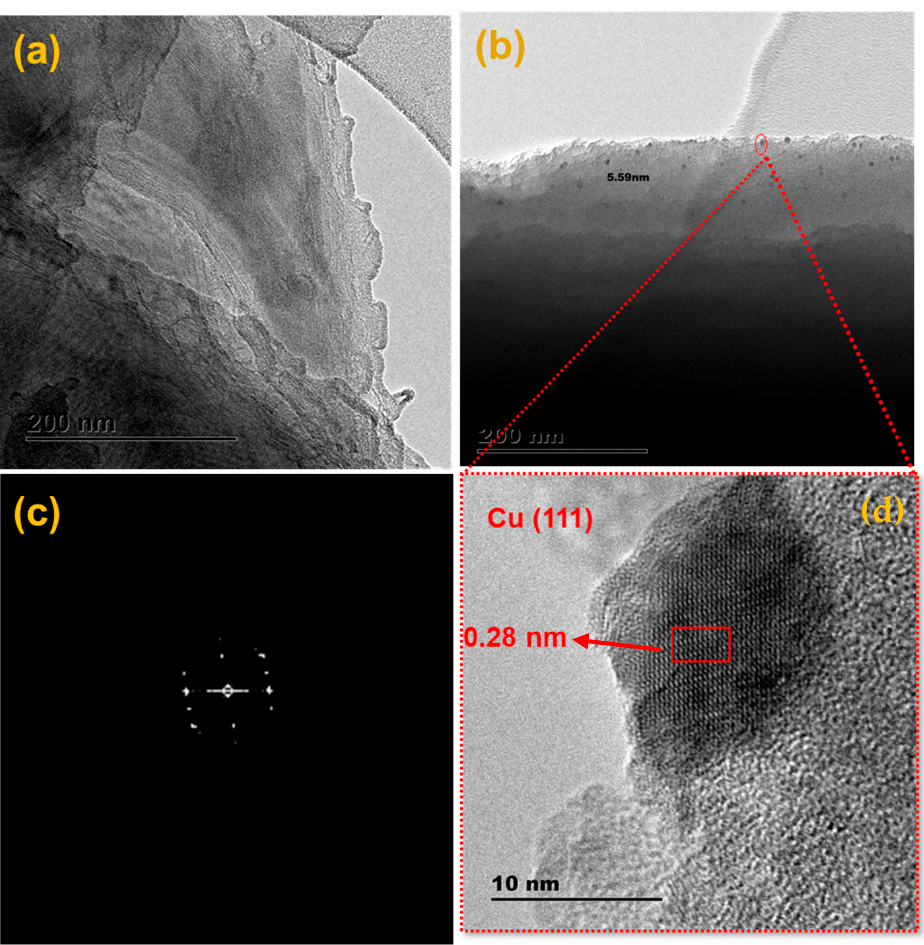
Figure 2. TEM images of ( a ) TFSA, ( b , d ) Cu@TFSA at two different magnifications, and ( c ) the corresponding FFT diffractogram of Cu@TFSA.